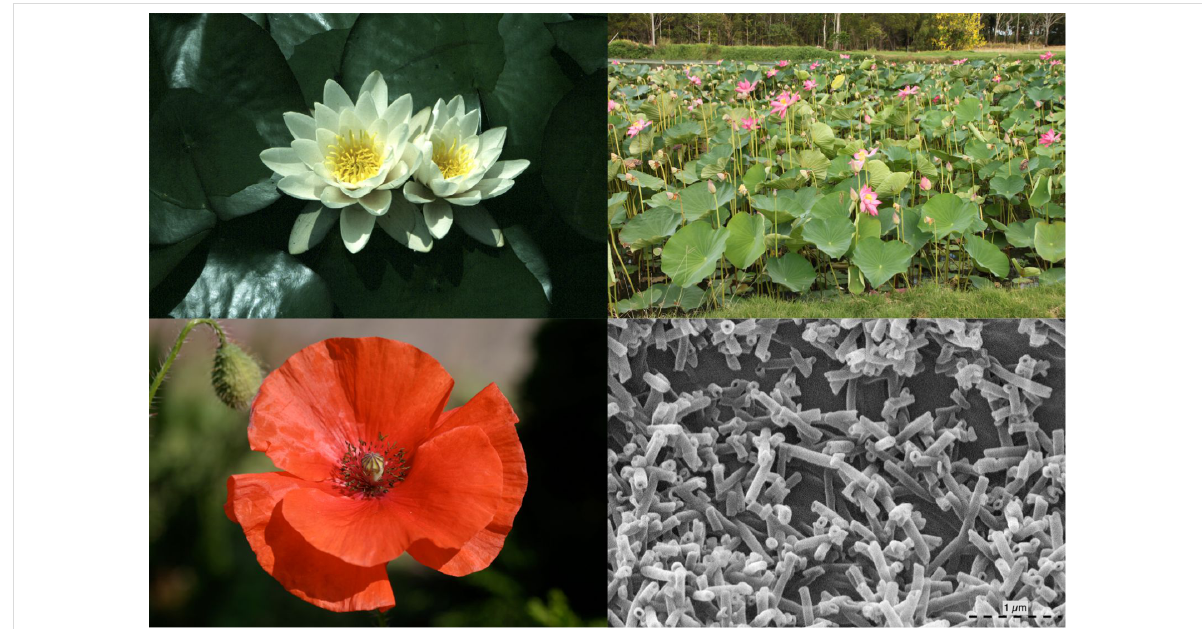
Figure 9: Is lotus related to water lilies (upper left) or poppies (lower left)? Epicuticular wax tubules (lower right) shared by ranunculids were one argu- ment to place Nelumbo (upper right) close to the latter systematic group.